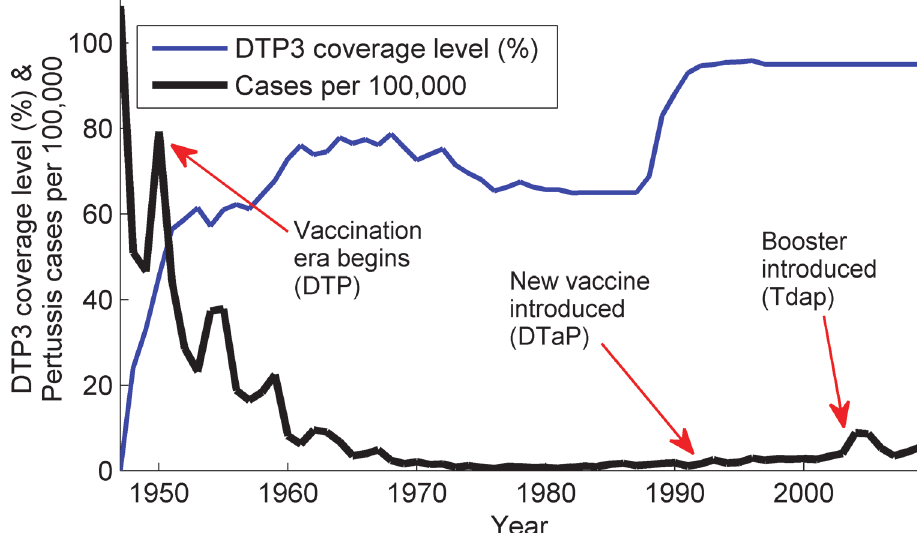
Fig 1. Incidence of disease and vaccination coverage in the United States. The time varying incidence of disease in the US, summed over all ages, between 1950 and 2009, annotated for significant events relating to vaccination policy. The blue solid line illustrates the DTP3 (first three DTP doses) vaccine coverage level over time.